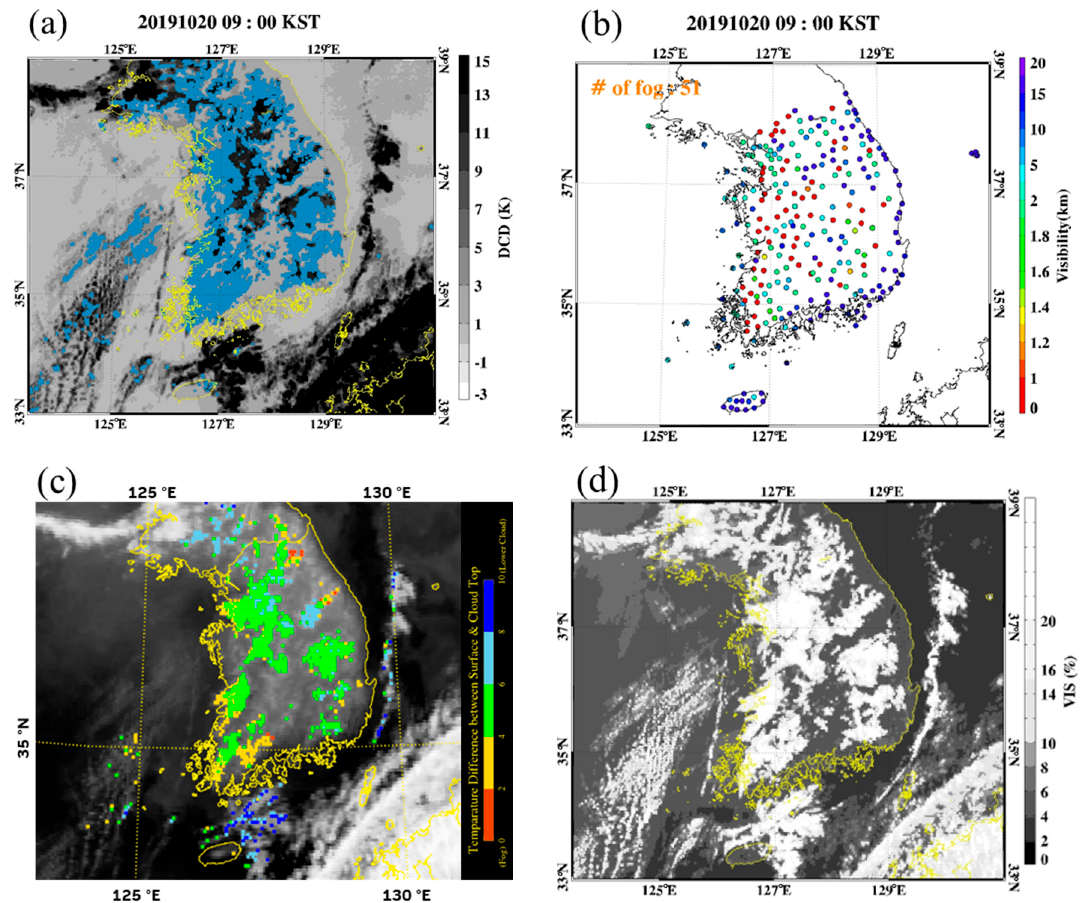
Figure 9. Sample image of fog detection results at 09:00 KST on 20 October 2019. ( a ) Fog image of GK2A_FDA, ( b ) ground-observed visibility, ( c ) fog image of CMDPS, and ( d ) image of visible channel (0.64 µ m). Sky blue color in ( a ) indicates foggy pixels.